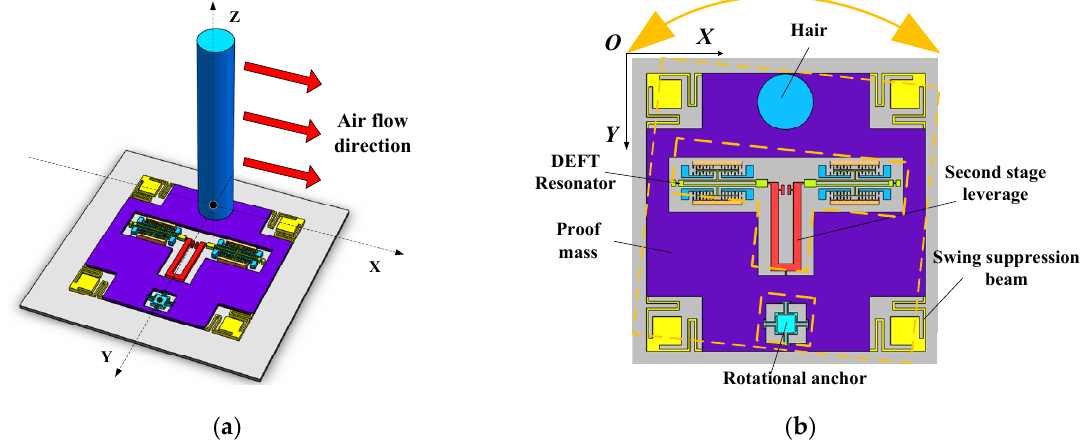
Figure 1. ( a , b ) Structure of the bionic hair sensor with resonant Figure 1. Structure of the bionic hair sensor with resonant readout.